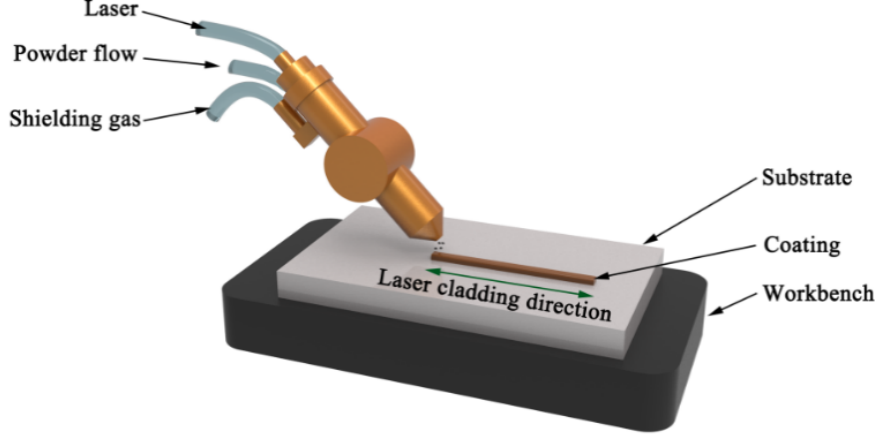
Figure 1. Schematic diagram of laser cladding. Table 3. Parameters for laser cladding.